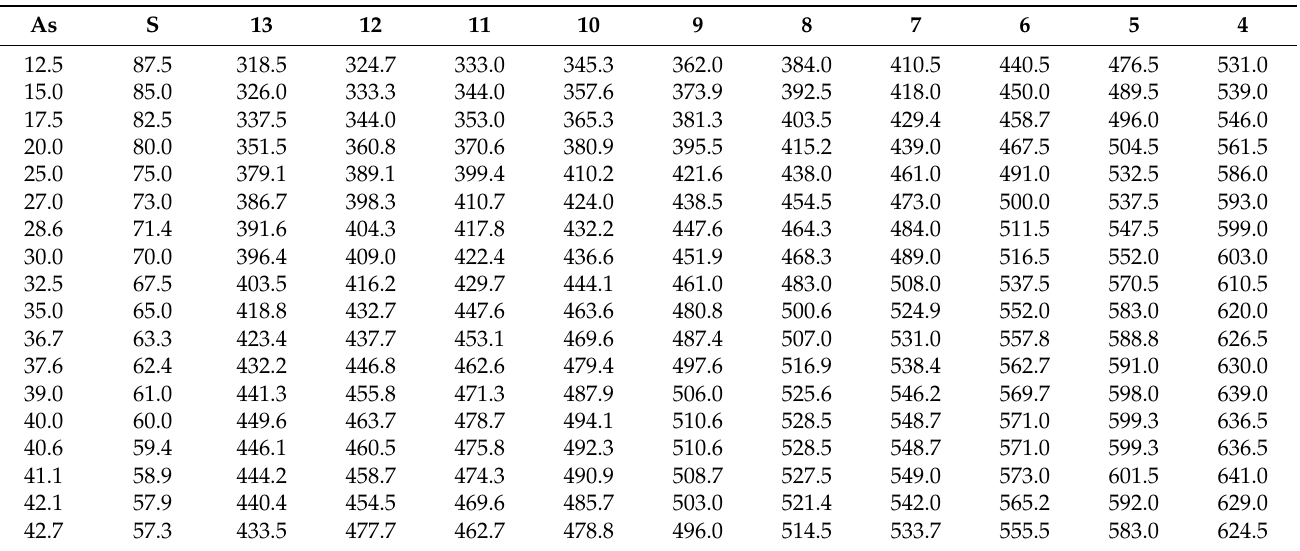
Table 2. Temperatures of As-S glasses of composition in mol%, temperature in K, at which the viscosity log[ η ( T ), poise] takes given